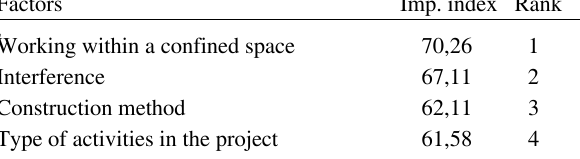
Table 7. Ranking factors under the project group